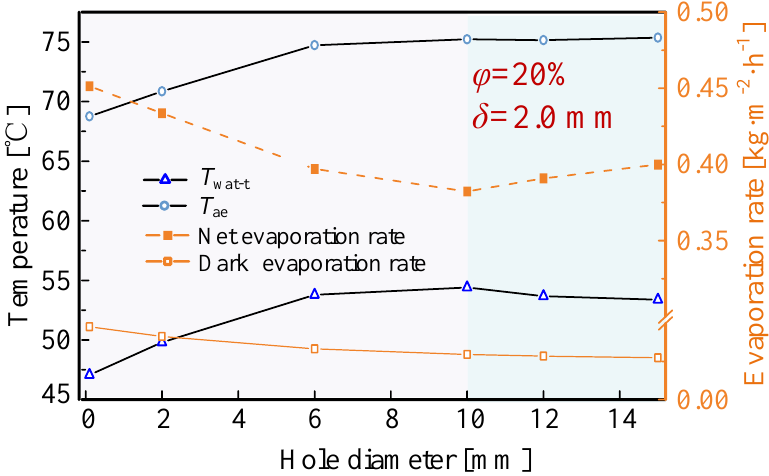
Figure 9. T ae , T wat-t and evaporation rate under different hole diameters, with the same hole area ratio ( φ = 20%) and air layer thickness ( δ = 2.0 mm).